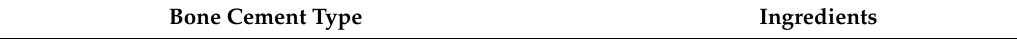
Table 1. Bone cement materials compared in the present study. Bone Cement Type